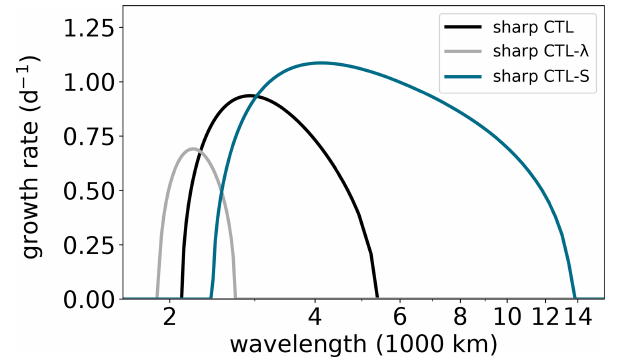
Figure 2. Growth rate vs. wavelength for the sharp CTL (black), CTL- λ (grey), and CTL-S (blue) experiments, where either λ and S , only λ , or only S are discontinuous,